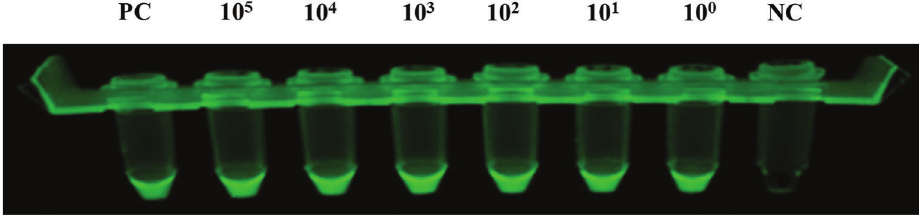
Figure 8. Fluorescence visualization of the loop-mediated isothermal ampli fi cation (LAMP) reaction tubes in the sensitivity test for detecting the target gene of ureR_1 . The lysed suspension of K. pneumoniae and mouse blood was used as the template for the LAMP test. The positive plasmid was the positive control (PC) and water was the negative control (NC). The concentration of bacterium was from 10 5 – 10 0 . The results were observed under UV-light. All experiments were repeated twice.